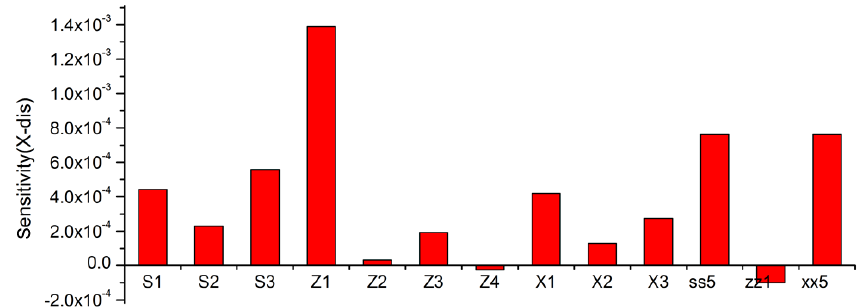
Figure 20. Sensitivity histogram of deformation displacement in horizontal ( X )